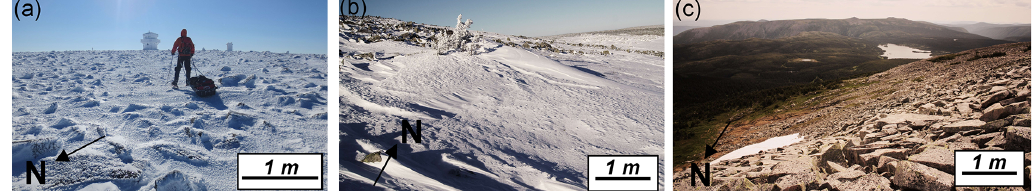
Figure 3. Photographs of Mont Jacques-Cartier. (a) Blockfield after a snowstorm in early April 2014. Even at the end of the winter the large blocks were still protruding from the shallow snowpack. (b) An isolated patch of krummholz on the south-east slope with typically leeward trailing snow accumulation zone (February 2012). (c) Long-lasting snow patch in the topographic depression of the leeward south-east slope at the end of July 2014.